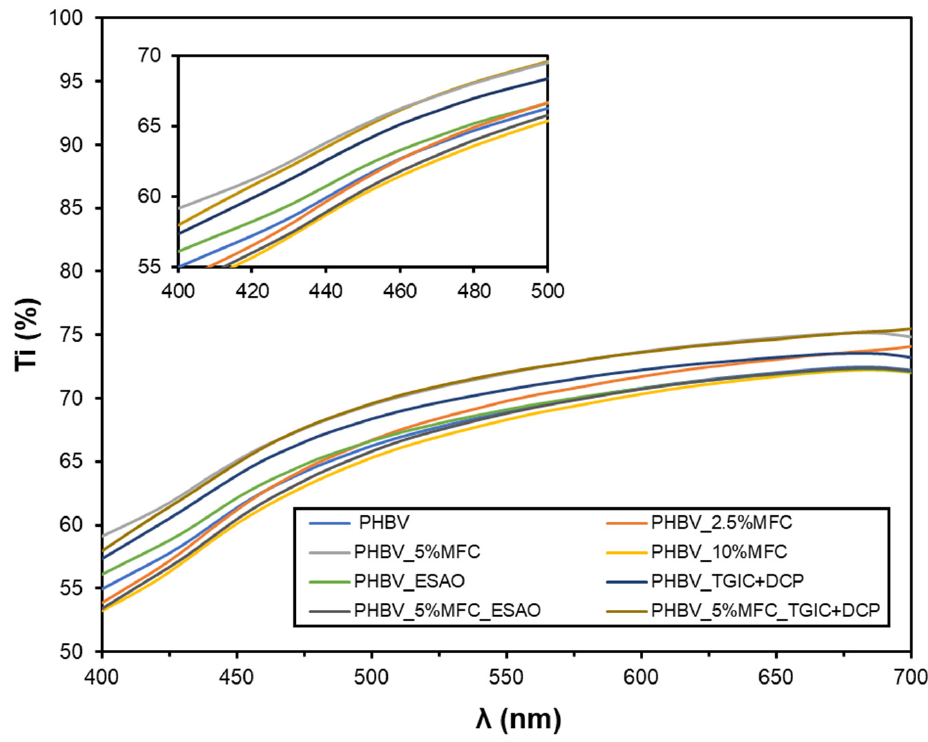
Figure 7. Spectral distribution curves of the percentage of internal transmittance (Ti) of the films of poly(3-hydroxybutyrate- co -3-hydroxyvalerate) (PHBV) with microfibrillated cellulose (MFC) and compatibilized with epoxy-based styrene-acrylic oligomer (ESAO) and with triglycidyl isocyanurate (TGIC) and dicumyl peroxide (DCP).